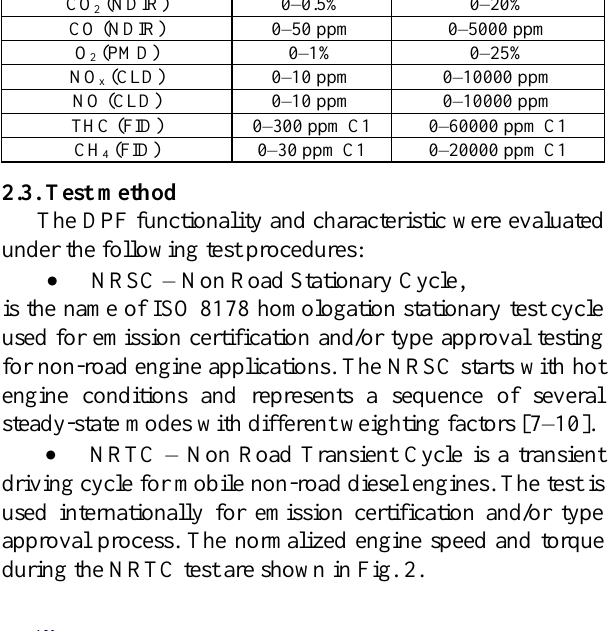
Table 2. Emission analyzers ranges Analyzer (principle of operation)